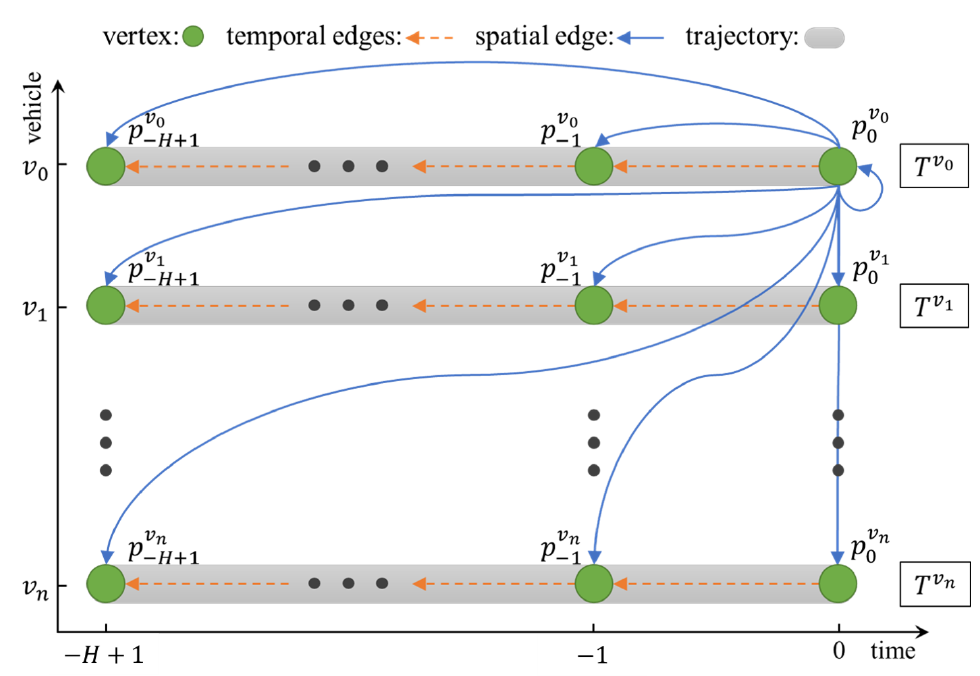
Figure 4. Structure of the spatiotemporal graph constructed using vehicle